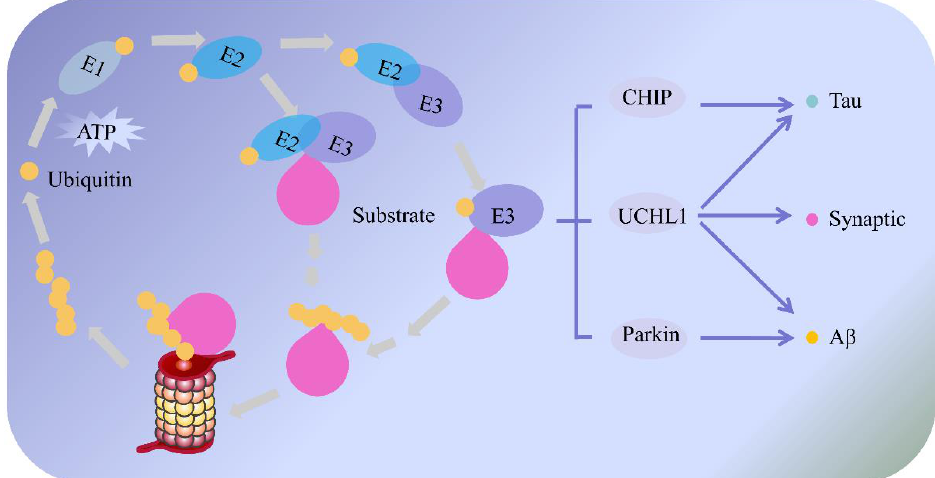
Figure 4. The mechanism of the ubiquitin–proteasome system and its potential role in Alzheimer’s disease. The ubiquitin–proteasome system includes two successive steps: ubiquitination and pro- teasome degradation. Initially, ubiquitin is activated by a ubiquitin-activated enzyme (E1) in an ATP-dependent process. Then, the activated ubiquitin is transferred to a ubiquitin-conjugating- enzyme (E2). Finally, E2 transfers the ubiquitin moiety from E1 to the target protein, which is recognized and tagged by the ubiquitin–protein ligase (E3). Following this tagging, the polyu- biquitinated substrates are transported to the 26S proteasome for degradation by the proteasome. Meanwhile, the UPS serves as a critical way to remove the accumulation of abnormal proteins and prevent the progression of AD. For example, as an important E3 ligase in the UPS, Parkin not only interacts directly with A β and decreases its accumulation, but also indirectly increases the clearance of A β via the proteasomal dependent pathway. CHIP is an E3 ubiquitin ligase that ubiquitinates Tau protein, thereby promoting the degradation of abnormally phosphorylated Tau protein. Moreover, the UCHL-1 is an E3 ligase and deubiquitination enzyme with the function of degrading abnormal protein and improving synaptic